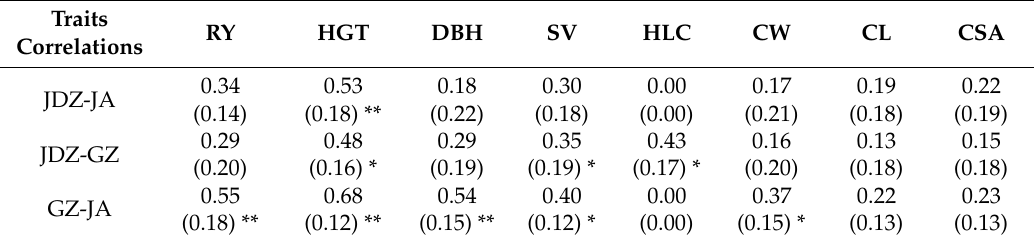
Table 5. Type B genetic correlations (with standard error in parenthesis) between sites for the resin yield, growth traits and morphologic traits of P. elliottii.